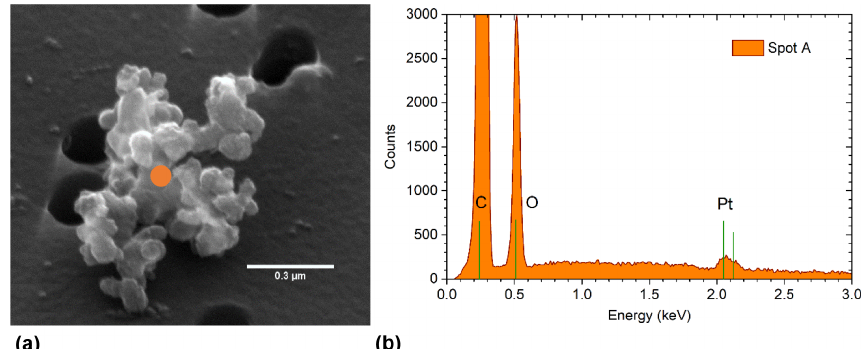
Figure 4. Morphology and composition of a fullerene soot particle extracted from the Marin-5 nebulizer output on a Nuclepore ™ filter. (a) The SEM secondary electron image. (b) EDX spectrum obtained from spot A on the particle (marked by the orange circle in the SEM image). The spectrum shows a pure carbonaceous signature with only the C and O peaks. Sample coating is responsible for the Pt peak at 2.08keV.